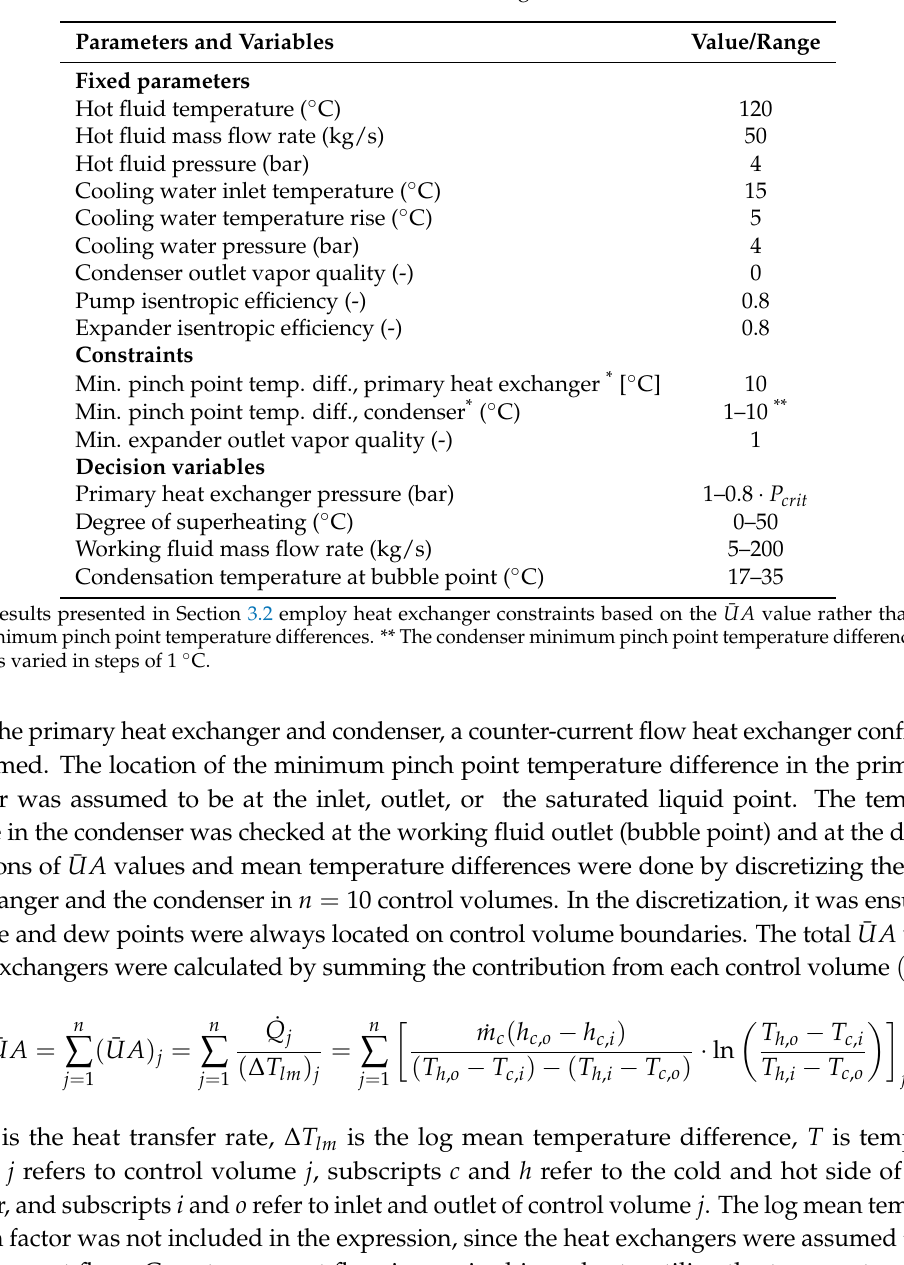
Table 1. ORC unit modeling